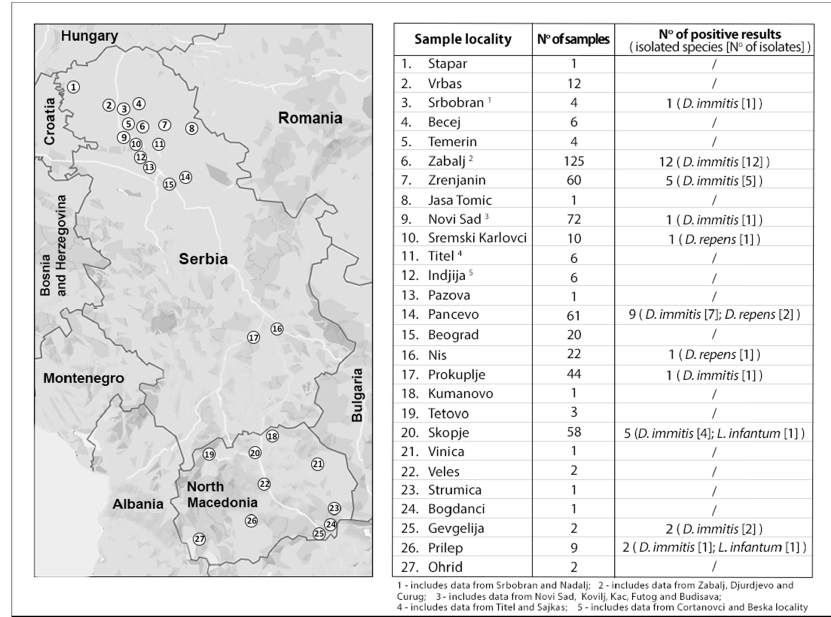
Figure 1. Prevalence of the infection in dogs from different areas of Central